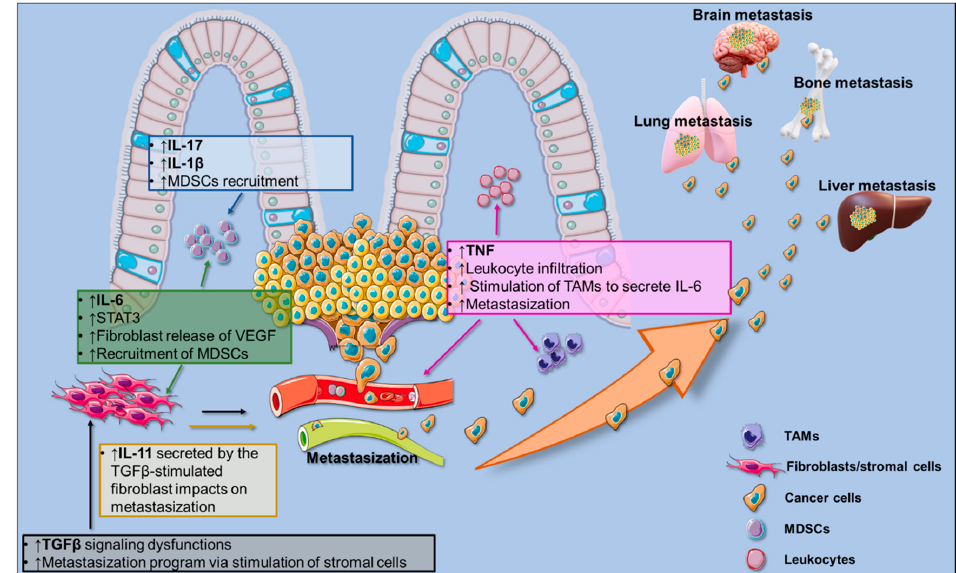
Figure 1. Pro-inflammatory milieu orchestrating colorectal cancer (CRC) growth and metastasization to the liver, lungs, and bones. Text boxes list specific cytokine (Interleukin (IL)-17, IL-1 β , Tumor Necrosis Factor Alpha (TNF α ), IL-6, and IL-11)-associated functions; arrows indicate cellular targets of CRC-associated cytokines. The illustration was made with SMART Servier Medical Art free images (https://smart.servier.com/).